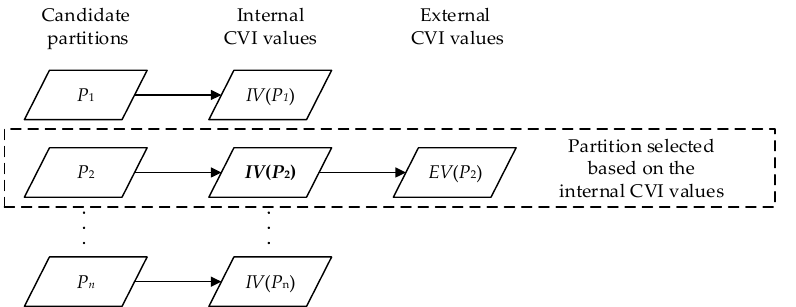
Figure 5. Determining the external index value of the partition selected by an internal index, where IV and EV are the values of the internal and the external index, respectively.